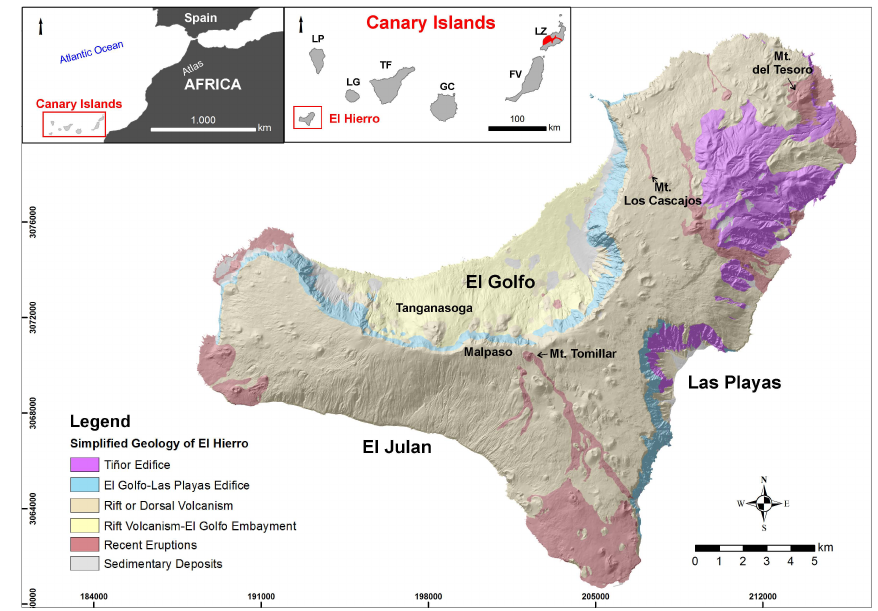
Figure 1. Geological map of El Hierro Island. At the left top part of the figure, location of the Canary Islands is presented where LZ represents Lanzarote; FV represents Fuerteventura; GC represents Gran Canaria; TF represents Tenerife; LG represents La Gomera; LP represents La Palma; EH represents El Hierro. Timanfaya eruption in Lanzarote has been coloured in